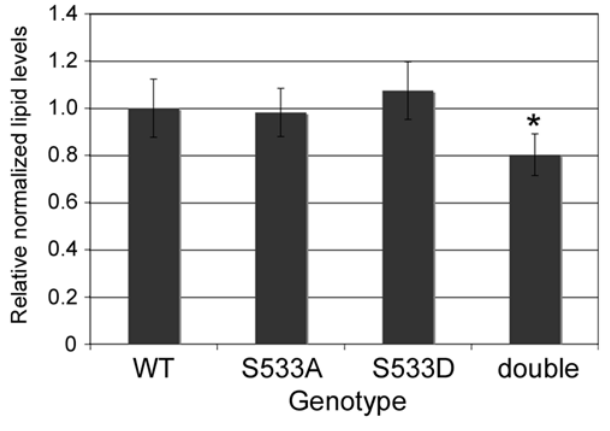
Figure 3. Flies lacking Akt phosphorylation sites on both Tsc1 and Tsc2 are slightly lean. Triglyceride levels normalized to total body protein for Tsc1 29 homozygotes rescued by ubiquitous expression of Tsc1 WT (‘‘WT’’), Tsc1 S533A (‘‘S533A’’) or Tsc1 S533D (‘‘S533D’’), or flies homozygous for both the Tsc1 29 and Tsc2 192 mutations rescued to viability by expression of both Tsc1 S533A and Tsc2 T437A/S924A/T1054A/T1518A (‘‘double’’). * indicates statistical significance (ttest=0.01).